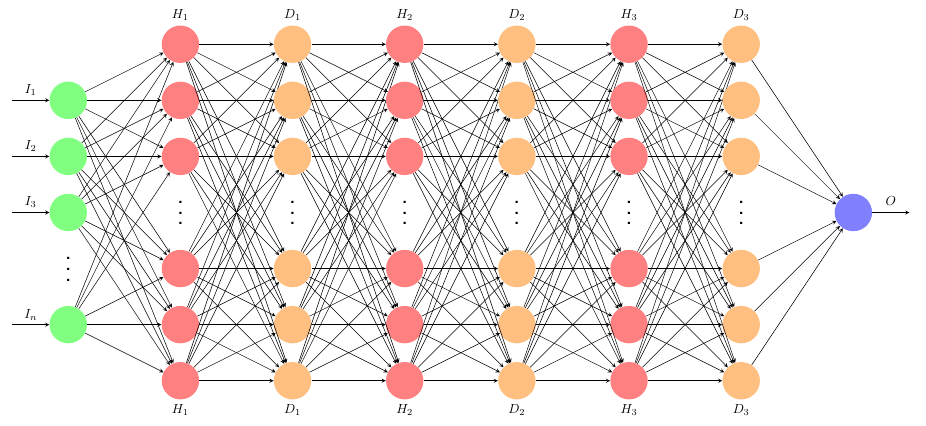
Figure 3. Structure of applied multi-layer